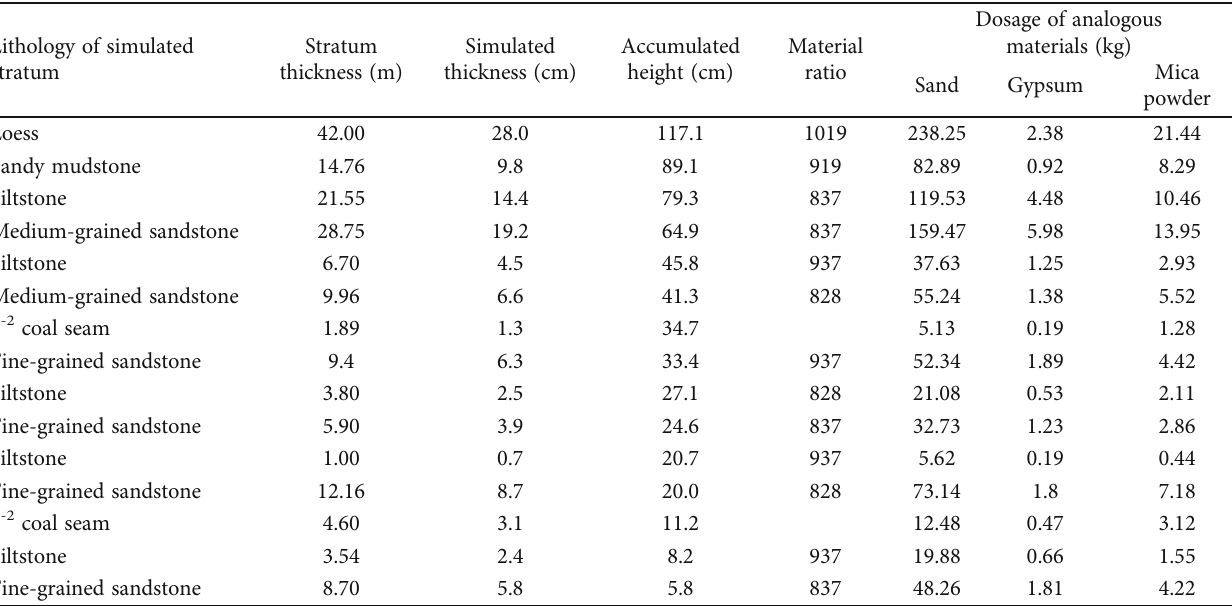
Figure 1: Monitoring principle of BOTDA. Table 1: Material ratios used in the similarity material